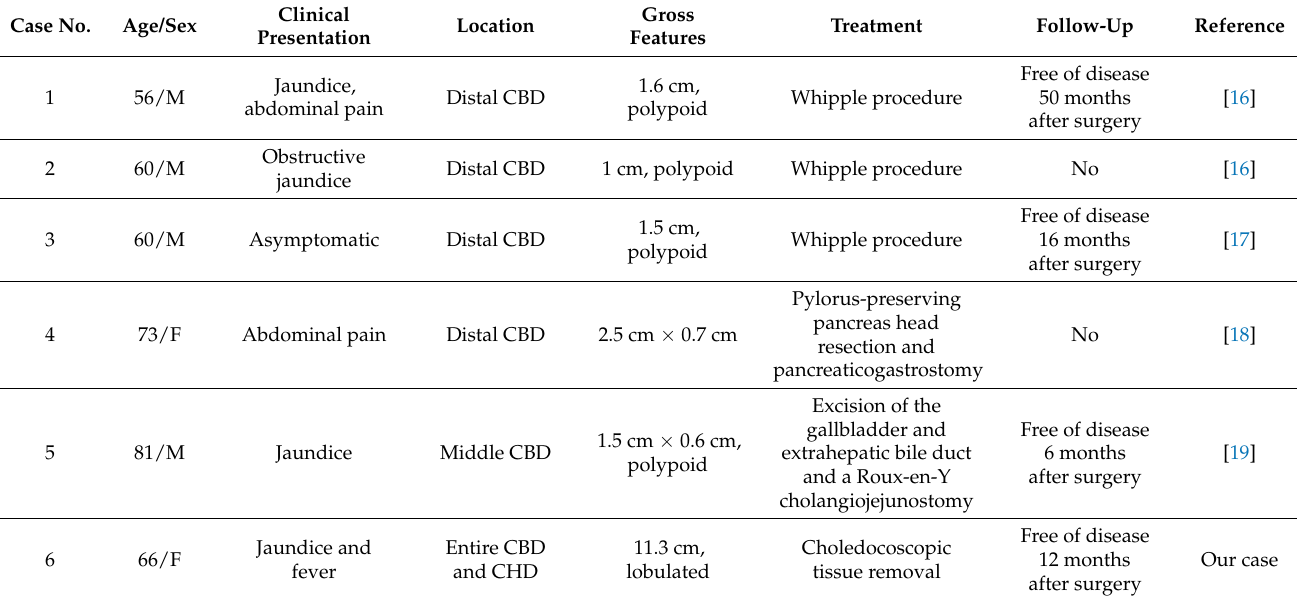
Table 1. Clinical features of cases with UCOGC of